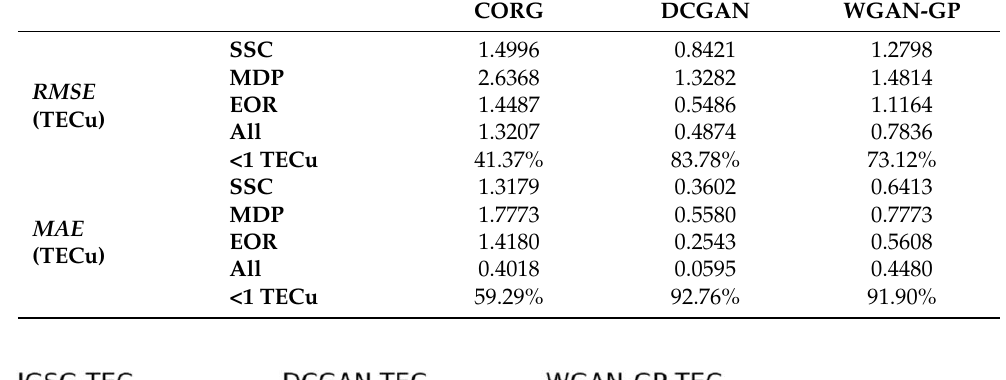
Table 5. RMSE and MAE performance during geomagnetic storm in September 2017.